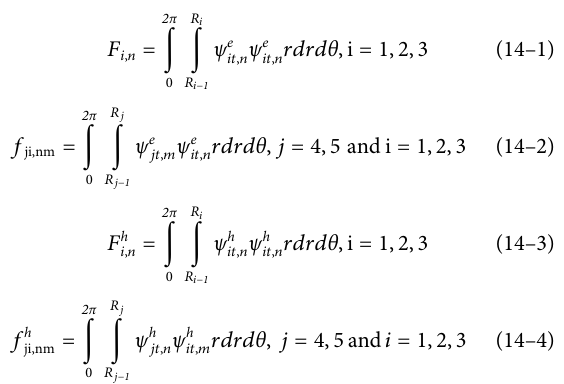
The dispersion curves of the guided modes in the nerve fi ber can be obtained by solving Eq. 7. The results are shown in Figure 3. Here, the radii of the three regions of the model are set at R 1 (cid:1) 8 μ m, R 2 (cid:1) 10 μ m, and R 3 (cid:1) 20 μ m (Kwon et al., 2017). The refractive indexes of the medium in the three regions are set as n 1 (cid:1) 2 . 1, n 2 (cid:1) 3 , and n 3 (cid:1) 2 (Liu et al., 2019), and the dielectric constants can be expressed as ε i (cid:1) n 2 i . Meanwhile, we will further investigate the effect of the difference in the dielectric constant between the myelin sheath, and the internal and external fl uids on the transmission of the THz-FIR wave. B is the relative propagation constant, which can be represented as B (cid:1) β z / k 0 . k 0 is the vacuum propagation (cid:8)(cid:8)(cid:8)(cid:8) √ ε μ constant and is expressed as k (cid:1) 0 (cid:1) ω . As shown in 0 0 Figure 3, we only show the case of m = 0, 1, 2, and 3, but in practice the mode order n can take any value. Because the outer boundary of the nerve fi ber is a metal tube wall with incomplete conductance, the tangential electric fi eld on the outer boundary surface is not zero and the transmitted electromagnetic waves will no longer be pure TE mode or TM mode. Similar to the structure of optical fi bers, the main transmission mode of terahertz waves in myelinated nerve fi bers is mainly HEM mixed mode. According to the dominance of electric and magnetic fi elds, the modes obtained under the nerve fi ber are denoted as the HEmn and EHmn hybrid modes when m > 1 (or TE0n or TM0n modes). As can be seen from the dispersion curves in Figures 3A, C, both myelinated and unmyelinated nerve fi bers transmit independent patterns, and each mode has a different propagation constant and corresponding transverse cutoff wavenumber at a given frequency. Hence, for any given excitation signal, the mode that satis fi es the transmission characteristics can be found by the dispersion